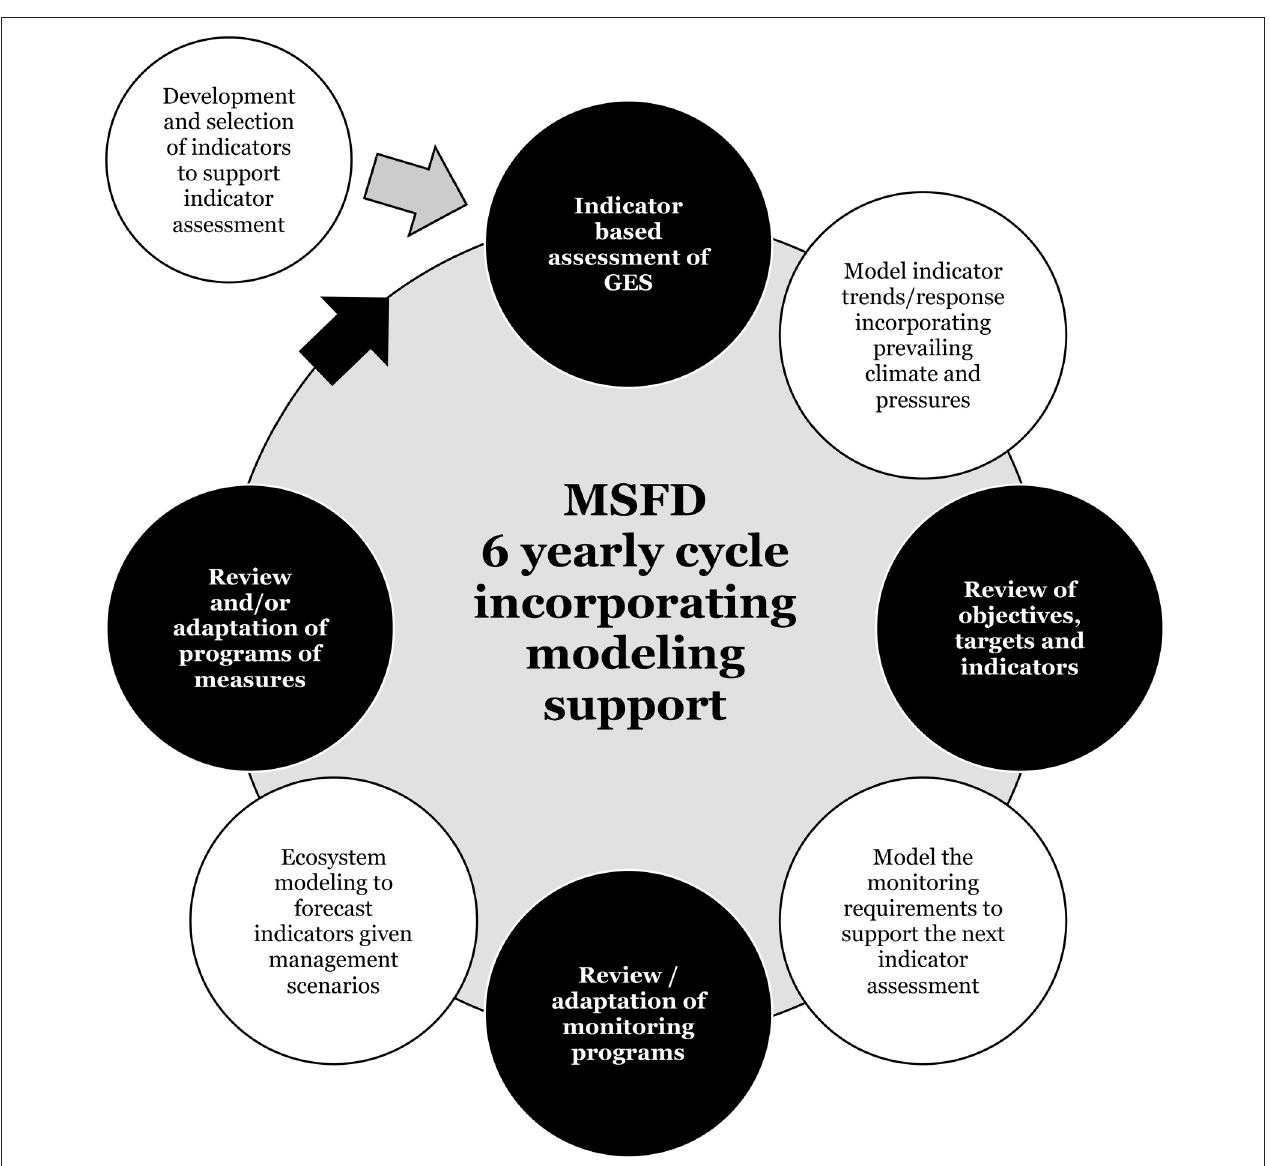
FIGURE 1 | Assessments of Good Environmental Status are made as part of an adaptive management approach with 6-yearly cycle and require modeling support at each step (key aims of the modeling required are presented in the white bubbles within the structure of the